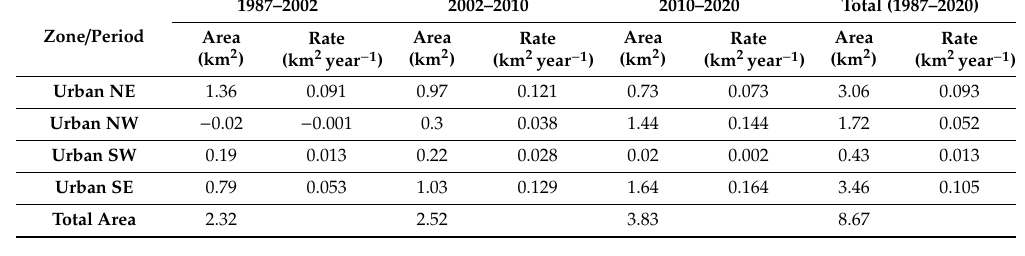
Table 4. Urban area changes and the change rate in all zones.